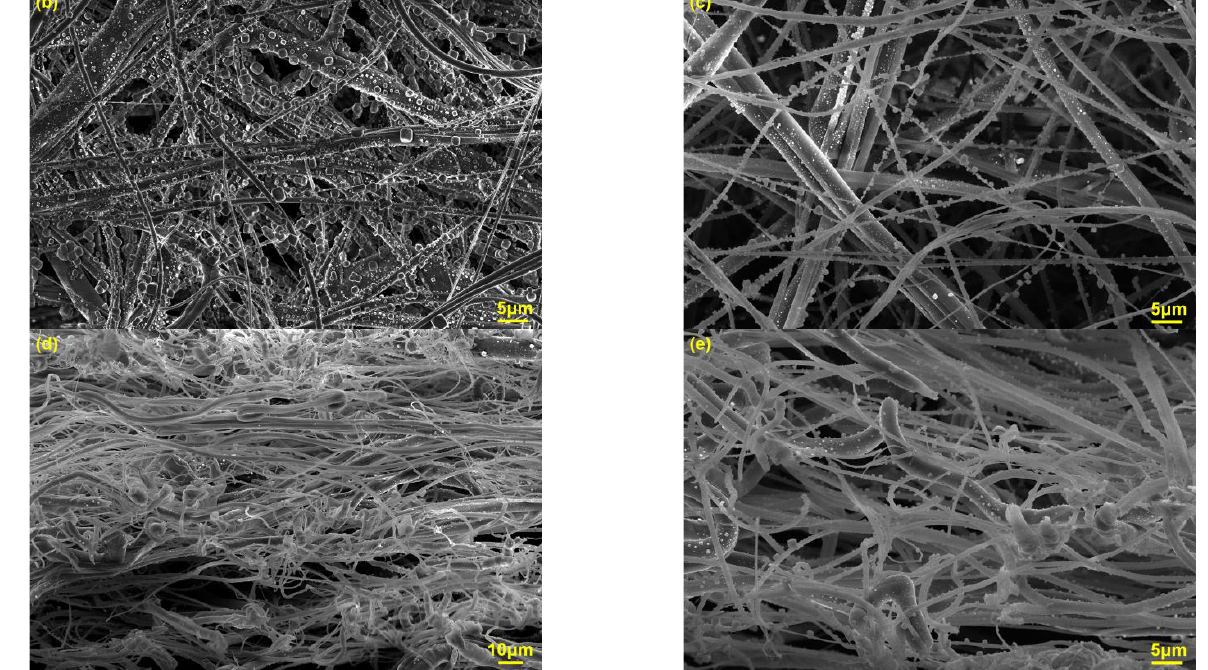
Figure 9. ( a ) Schematic diagram of filtration process. SEM images of M 3 E 3 *5 after loading ( b ) surface meltblown layer, ( c ) bottom nano layer, and ( d , e ) the cross section at different magnifications.